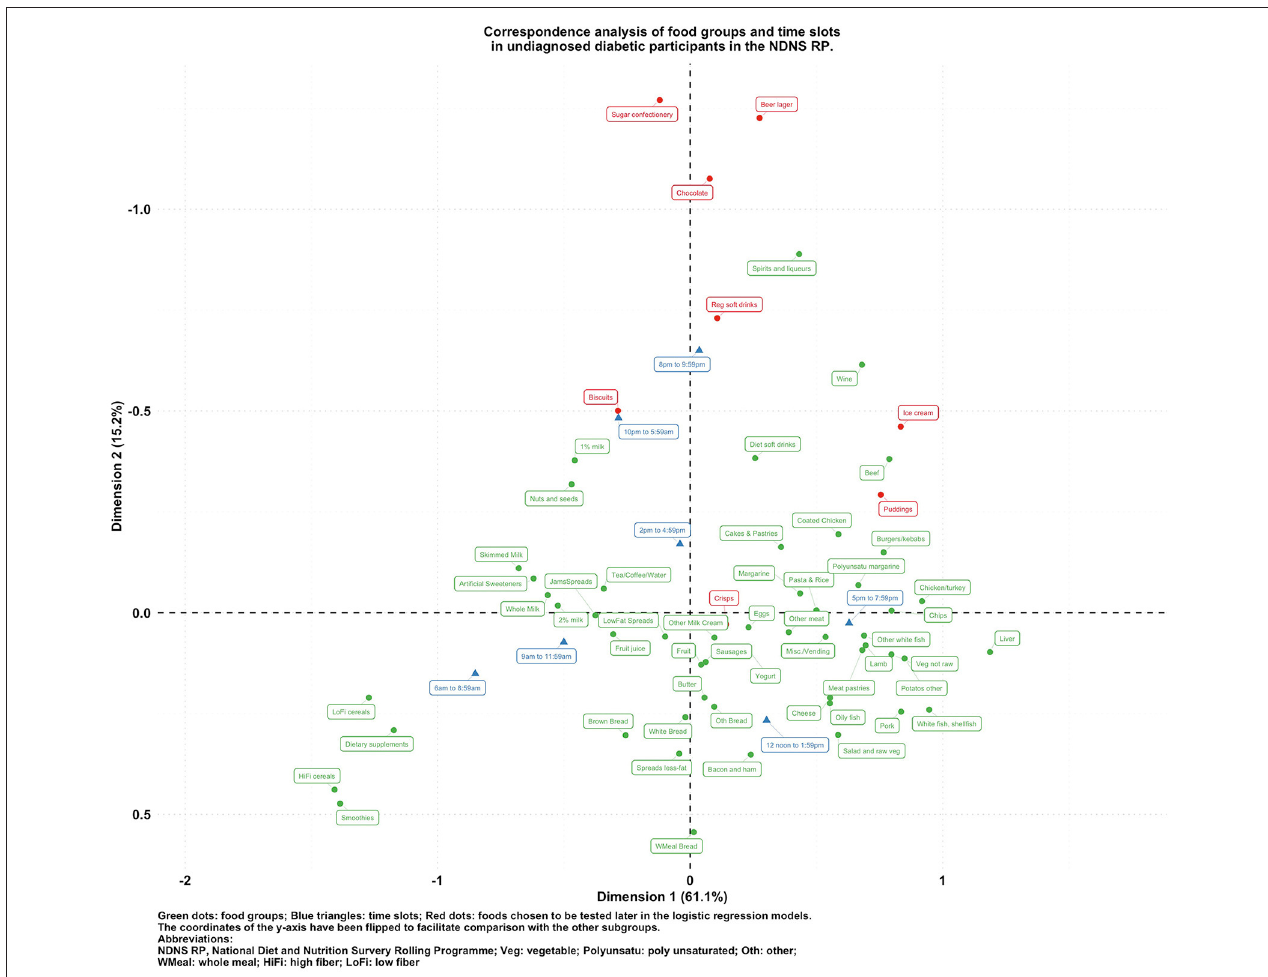
FIGURE 4 | Biplot of food groups and eating time slots in undiagnosed diabetic participants in the NDNS RP.